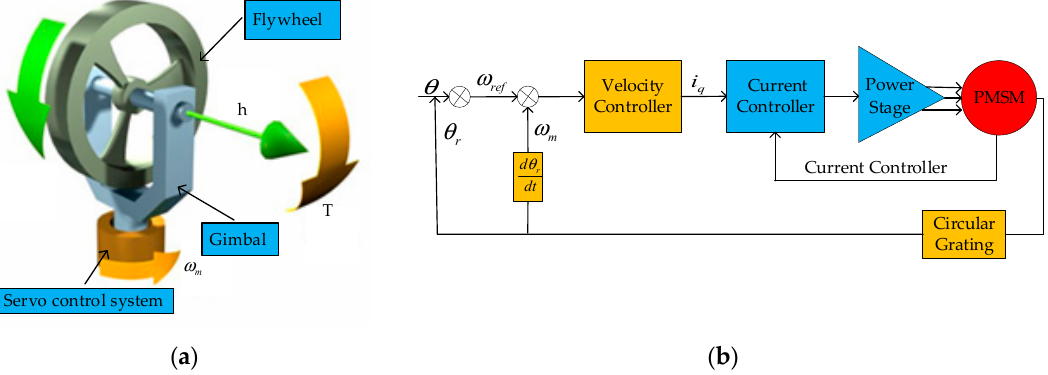
Figure 1. ( a ) System working principle diagram; ( b ) SGCMG gimbal servo control system structure